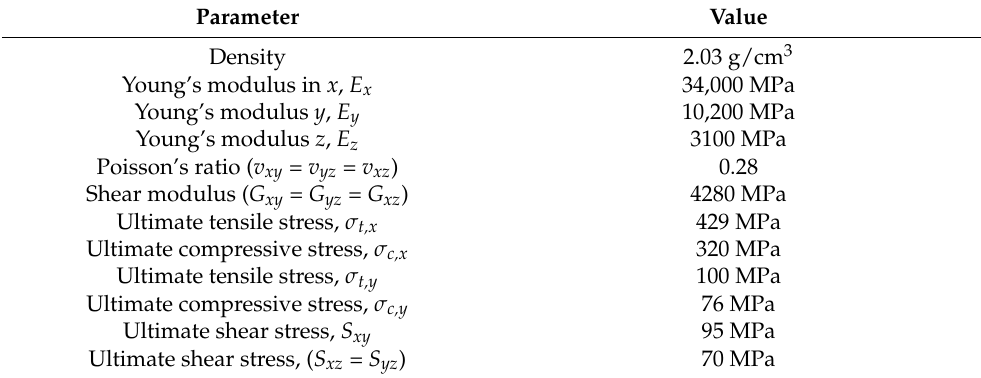
Table 2. Mechanical properties of GFRP composite cross-arm tube.